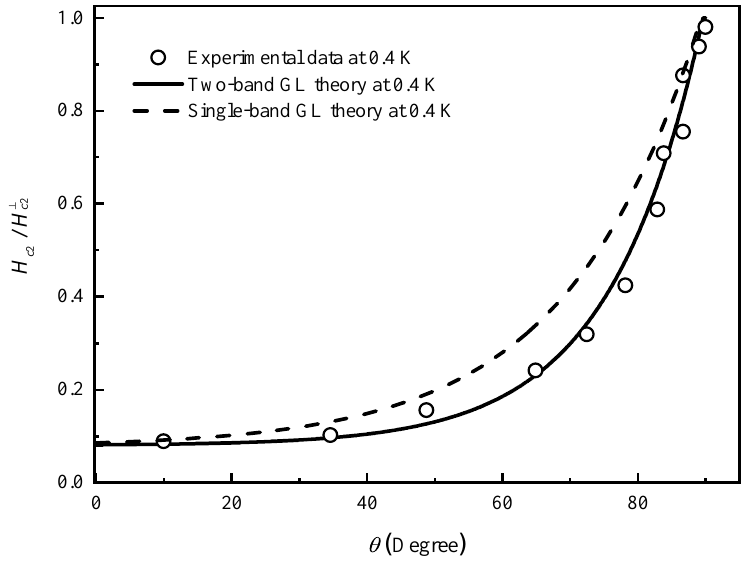
Figure 3. The angular ( θ ) dependence of the upper critical magnetic field at T = 0.4 K for the NbSe 2 thin film, and θ is in the unit of degree. The experimental data of NbSe 2 with the thickness d = 2.0 nm are taken from Ref.